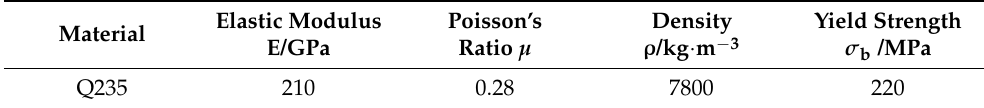
Figure 5. Simplified model of the resonant beam. Table 1. Main parameters of resonant beam material. Table 1. Main parameters of resonant beam material.